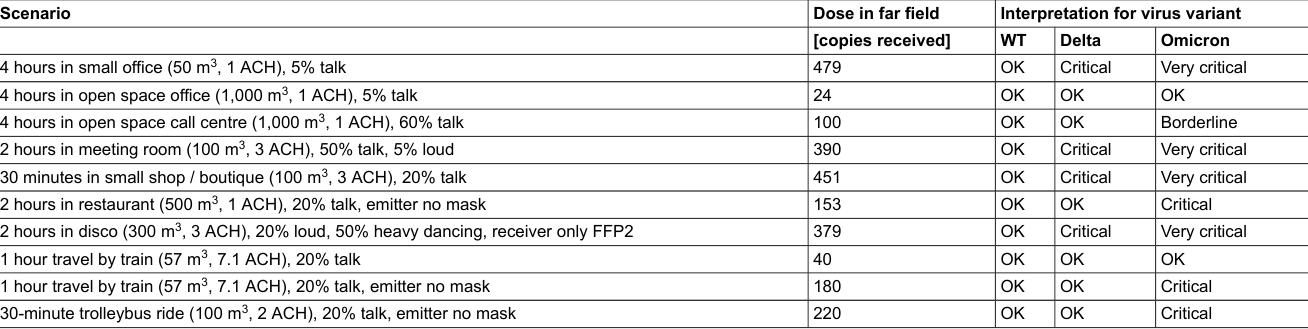
Table 2: Consequences of lower critical doses for frequent public situations in the presence of a super-emitter. Everybody is wearing surgical masks unless otherwise indicated (partly re- produced from [2] under CC BY 4.0). ACH: air changes per hour. Vocal intensity: “talk” = low intensity vocal activity. Interpretation: “critical" = above critical dose, “very critical” = more than twice critical